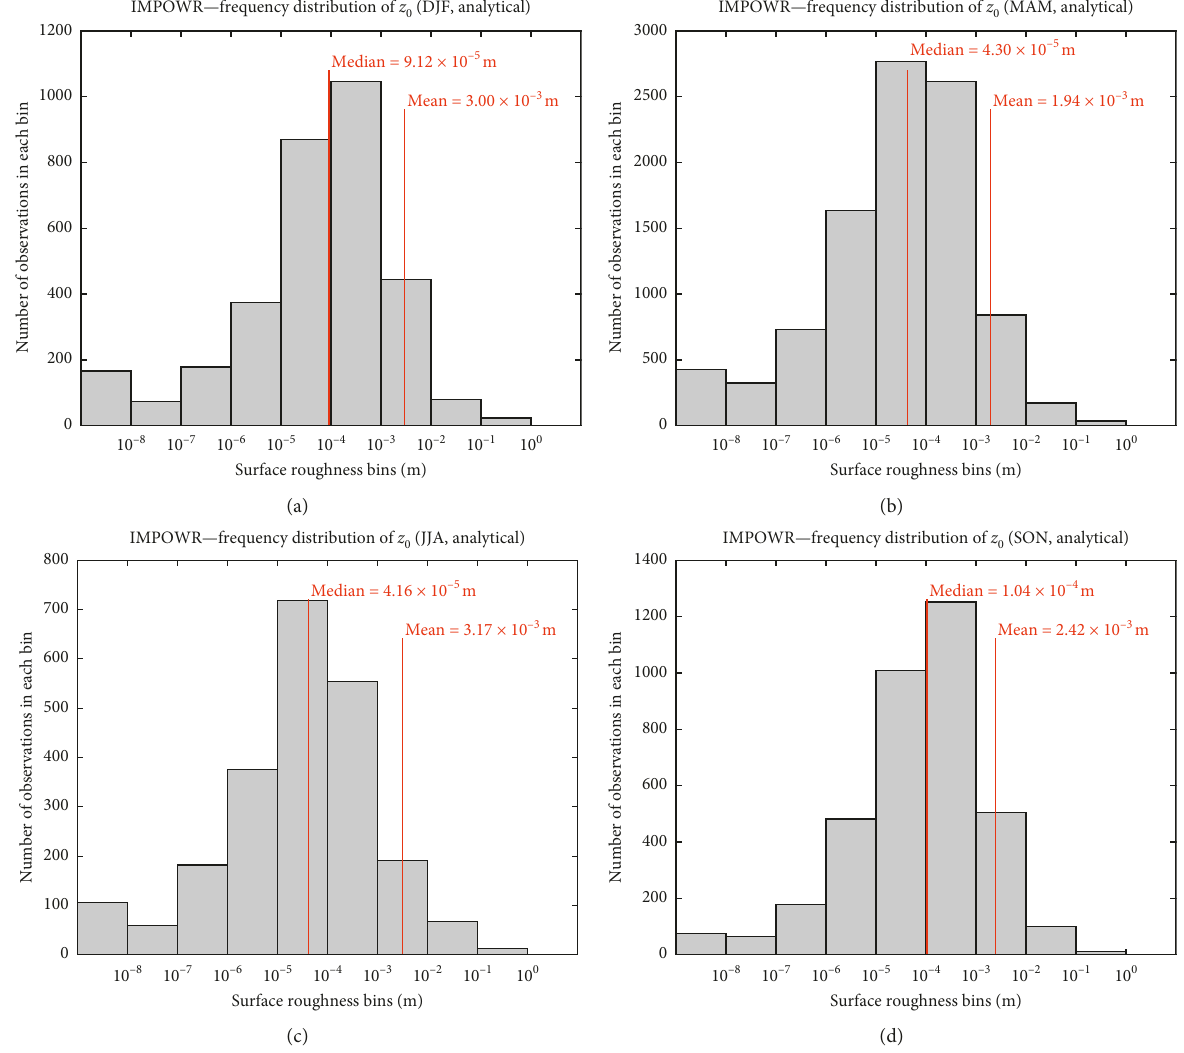
Figure 4: Frequency distribution of surface roughness length during the 2013–2014 IMPOWR campaign using two sonic anemometers located at 12 m AMSL for (a) December-January-February (DJF); (b) March-April-May (MAM); (c) June-July-August (JJA); and (d) September-October-November (SON). The mean and median z 0 are displayed on each figure. The x -axis is logarithmic and the y -axis has different maxima in each